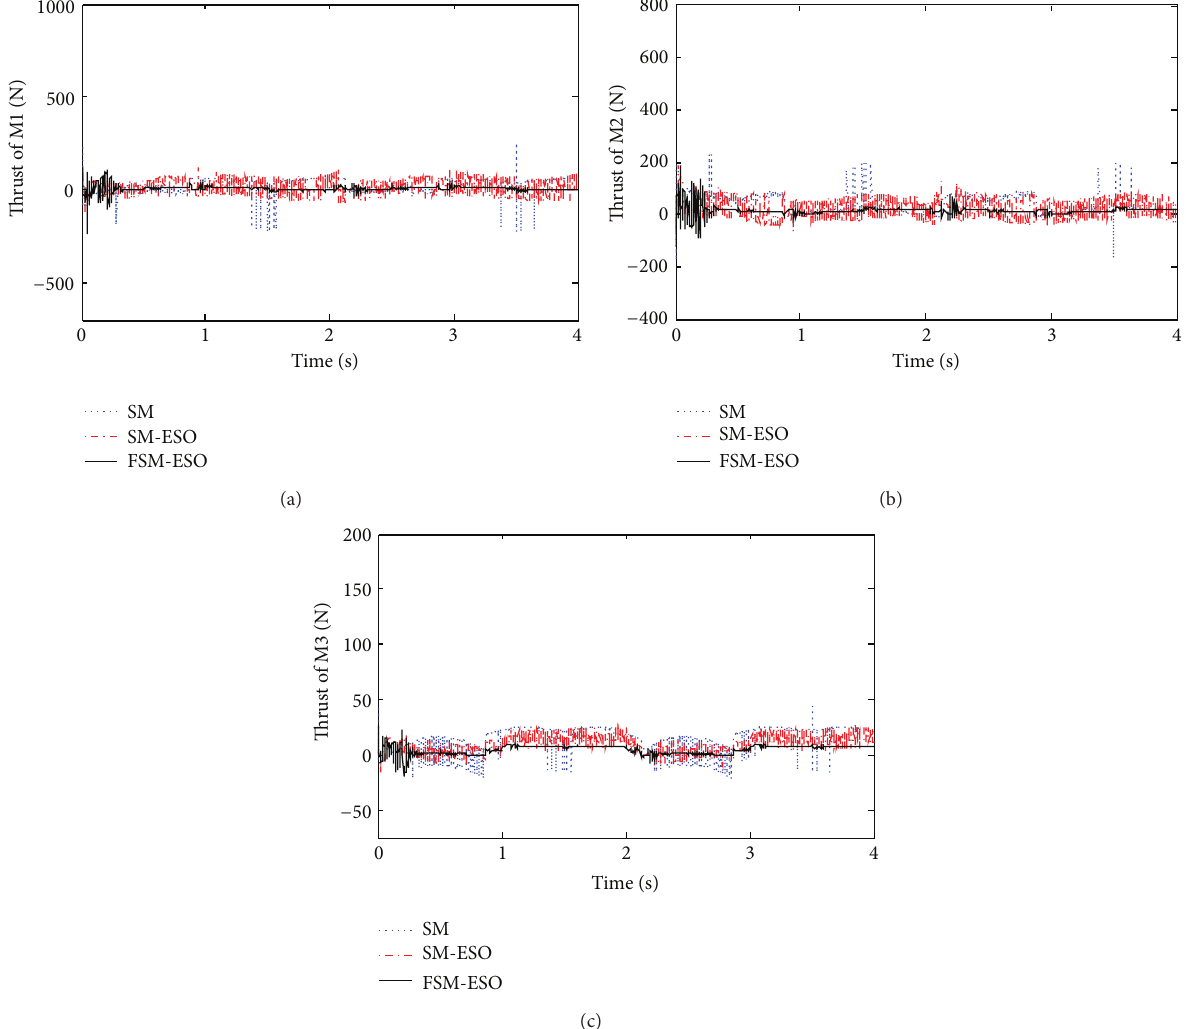
are K = diag (30, 30, 30) . For the conventional SMC, Λ = diag (16, 21, 18) and k = diag (5, 5, 5) . For SMC-ESO, Λ = diag (3, 7, 4) and k = diag (5, 5, 5) . For FSMC-ESO, Λ